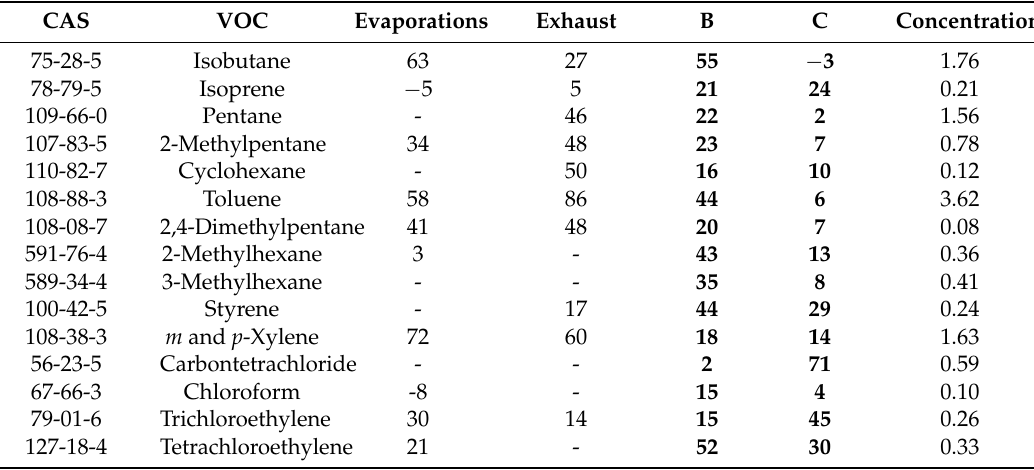
Table 7. Profiles of point sources B and C detected at station #60413, shown with the traffic profiles “Evaporations” and “Exhaust.”